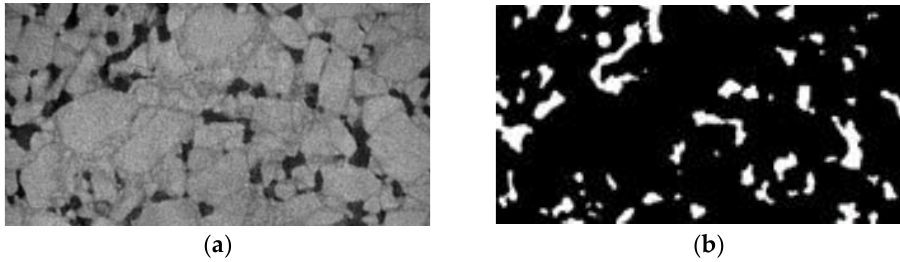
Figure 4. CT image segmentation: ( a ) Original CT scan image; ( b ) Identified void structure.